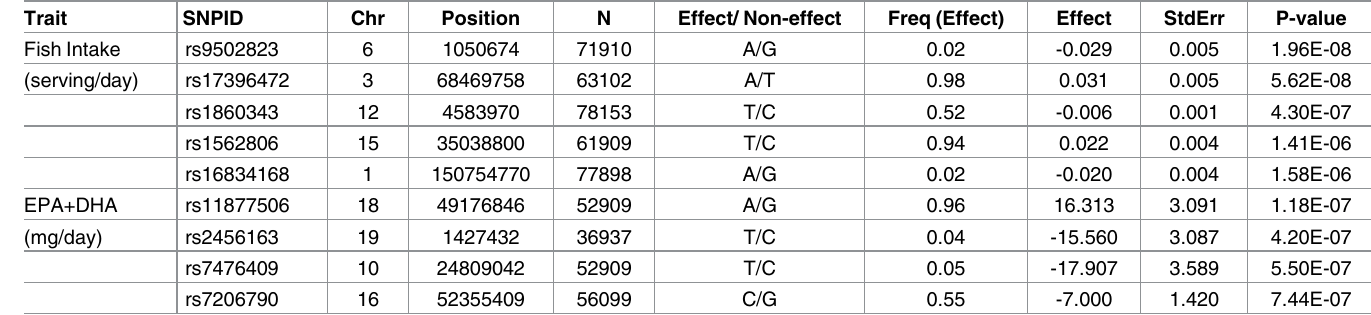
Table 2. The most significant associations from genome-wide association meta-analysis of fish and